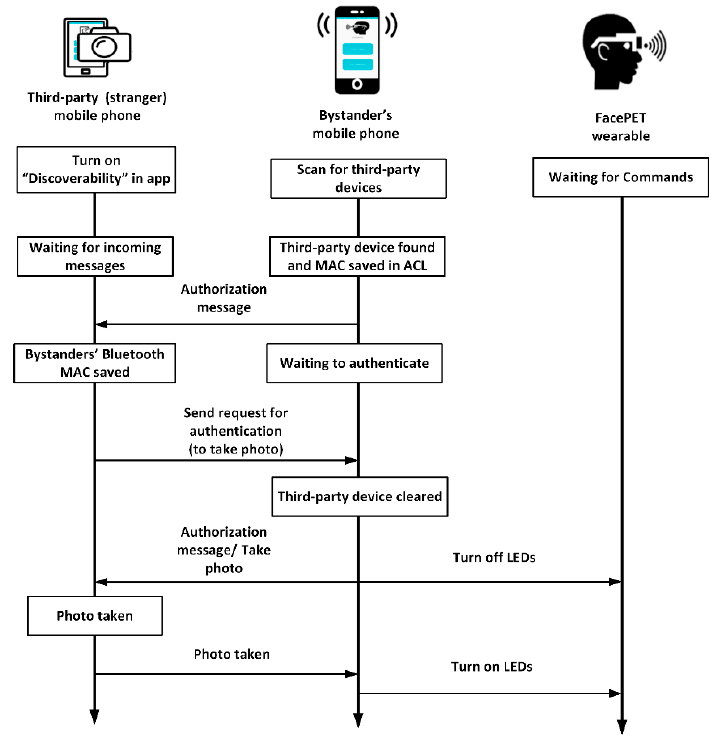
Figure 8. Sequence diagram for FacePET’s consent protocol.